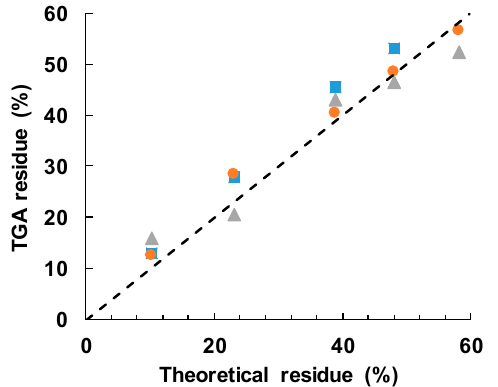
Figure 9. Measured TGA residue after degradation to 600 ◦ C as a function of the theoretical value: 2 µ m, blue squares; 30 µ m, orange circles; 180 µ m, grey triangles. The dashed line has a slope of